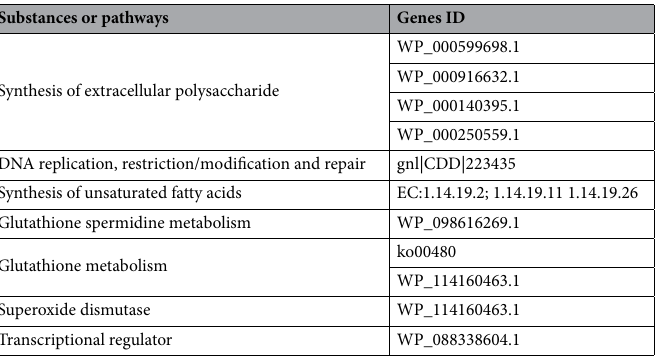
Table 3. Statistics of genes related to cold adaptation among the unique genes of Bacillus sp.